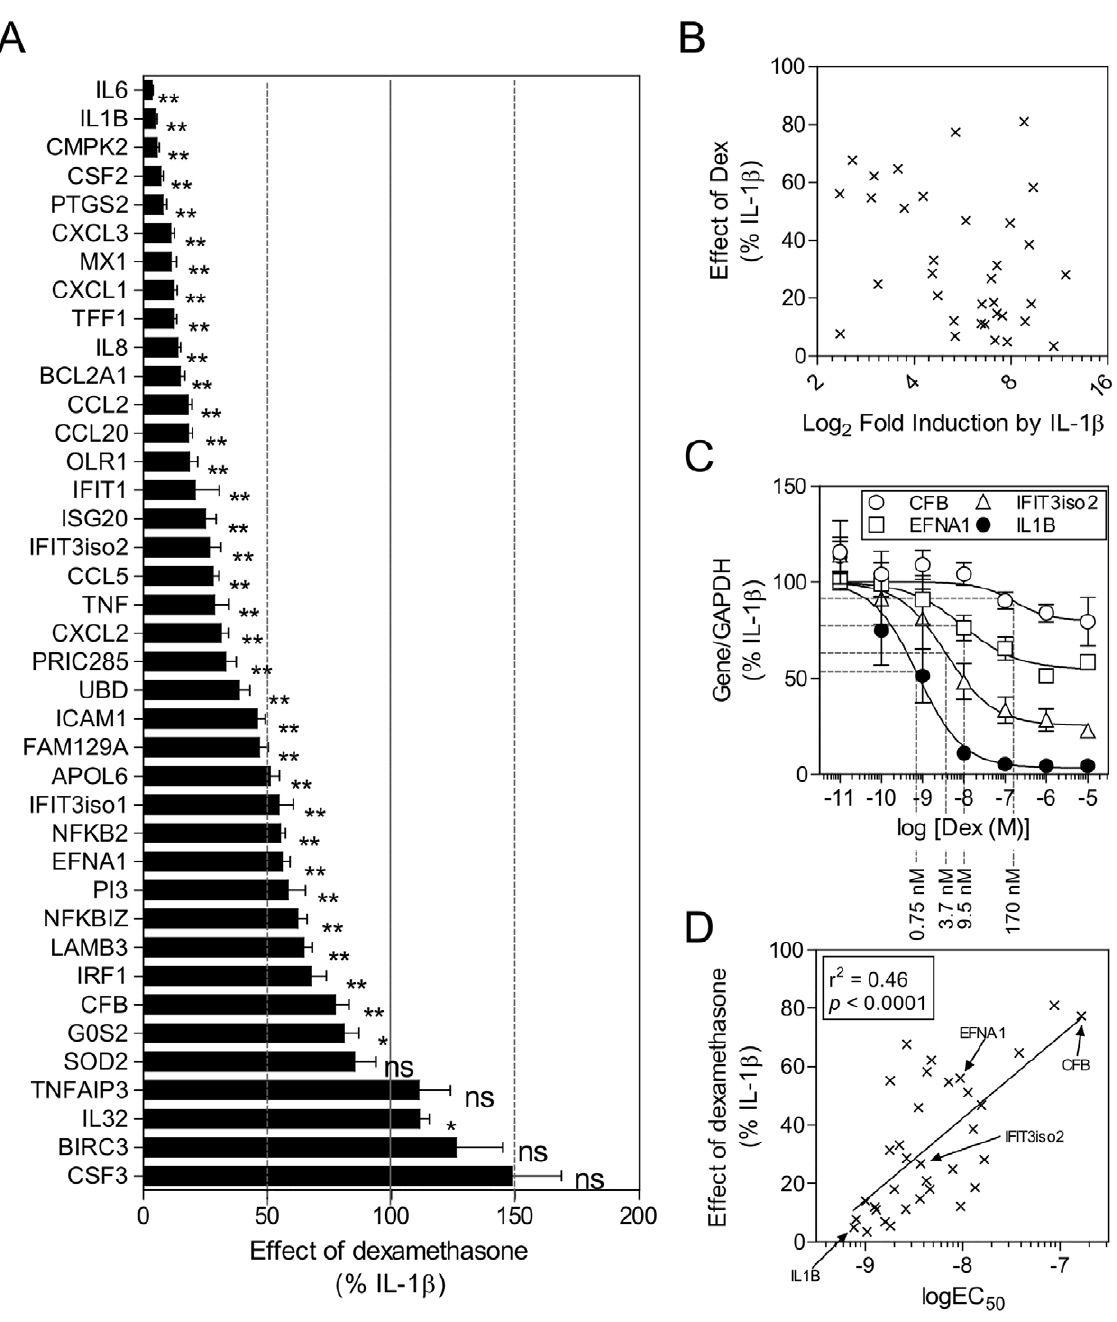
Figure 2. Effect of dexamethasone on inflammatory gene expression. A. The effect of dexamethasone (1 m M) is shown on the induction of inflammatory genes by IL-1 b (1 ng/ml) at 6 h. Data from Figures S2 and S3 were combined and the effect of dexamethasone expressed as a percentage of IL-1 b for each gene. 100% indicates no effect of dexamethasone. Data (n=9) are plotted as means 6 SE. Genes are listed by descending efficacy to repression by dexamethasone. Statistical analysis was performed by non-parametric paired t-test. * P , 0.05; ** P , 0.01. B. Relationship between induction by IL-1 b and repression by dexamethasone. The effect of dexamethasone (1 m M) expressed as a percentage of IL-1 b is plotted against the fold induction of each gene. Data are derived from Figure 2A and Figure S2. Linear regression was performed using GraphPad Prizm software. C. Repression by dexamethasone is shown for the most highly sensitive gene (IL-1 b ), two genes showing intermediate sensitivity (EFNA1 & IFIT3 isoform 2) and the lowest sensitivity gene (CFB) (that showed significant repression by 1 m M dexamethasone). Actual EC 50 values are indicated. D. Relationship between the effect of 1 m M dexamethasone (efficacy) and the sensitivity (log EC 50 ) of the repression by dexamethasone for individual genes. The effect of dexamethasone (1 m M) expressed as percentage of IL-1 b is plotted against the log EC 50 for the repression of each gene. Data are derived from Figure 2A and Figure S3 respectively. Linear regression was performed using GraphPad Prizm software. doi:10.1371/journal.pone.0053936.g002 I k B aD N (Figure 4C). In all cases, with the exception of NFKBIZ, sion of all 39 mRNAs to be significantly prevented by Ad5- where inhibition was modest, IL-1 b -induced mRNA expression